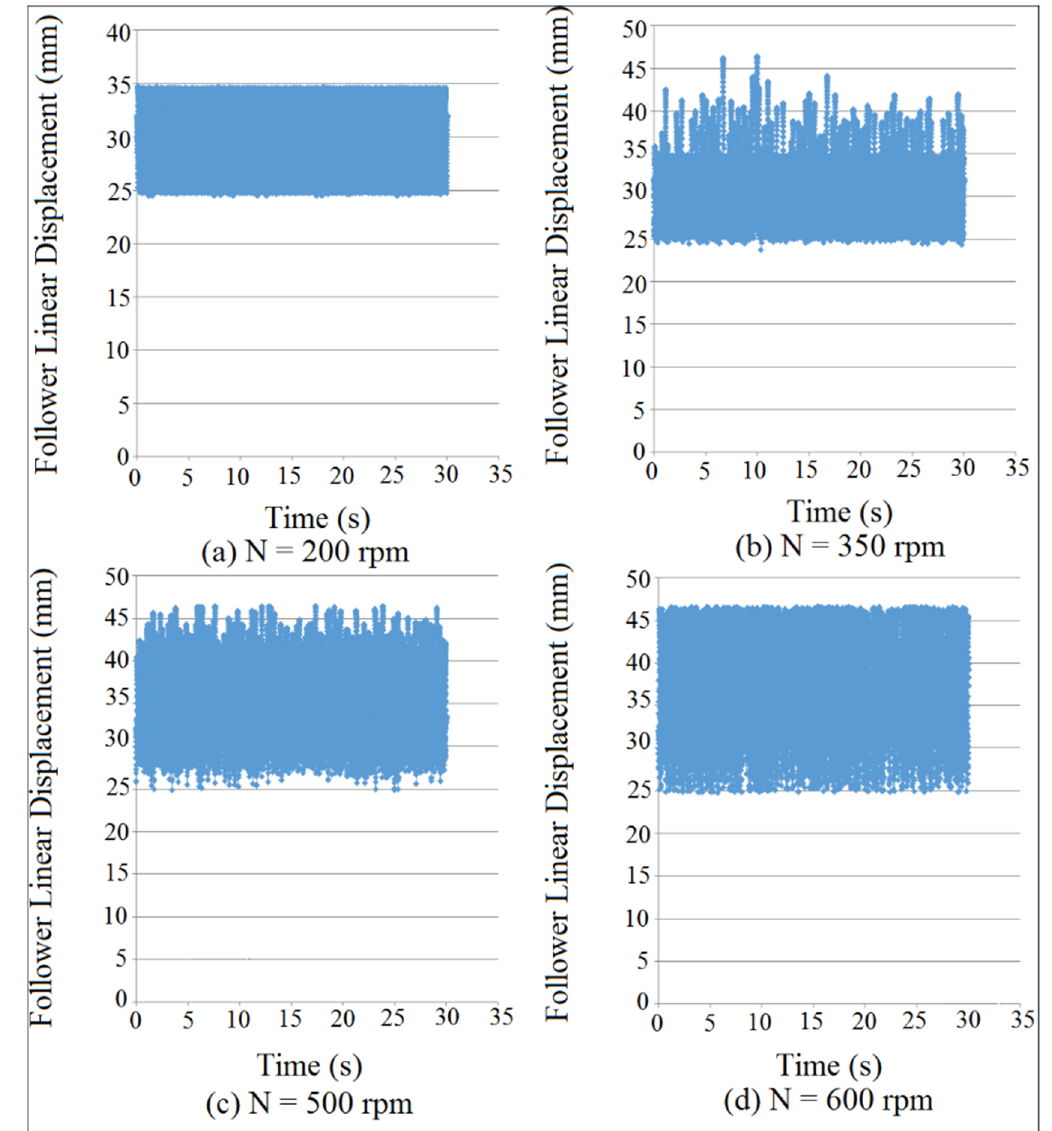
Figure 29. Follower linear displacement mapping against time for (I.D. = 18 mm).